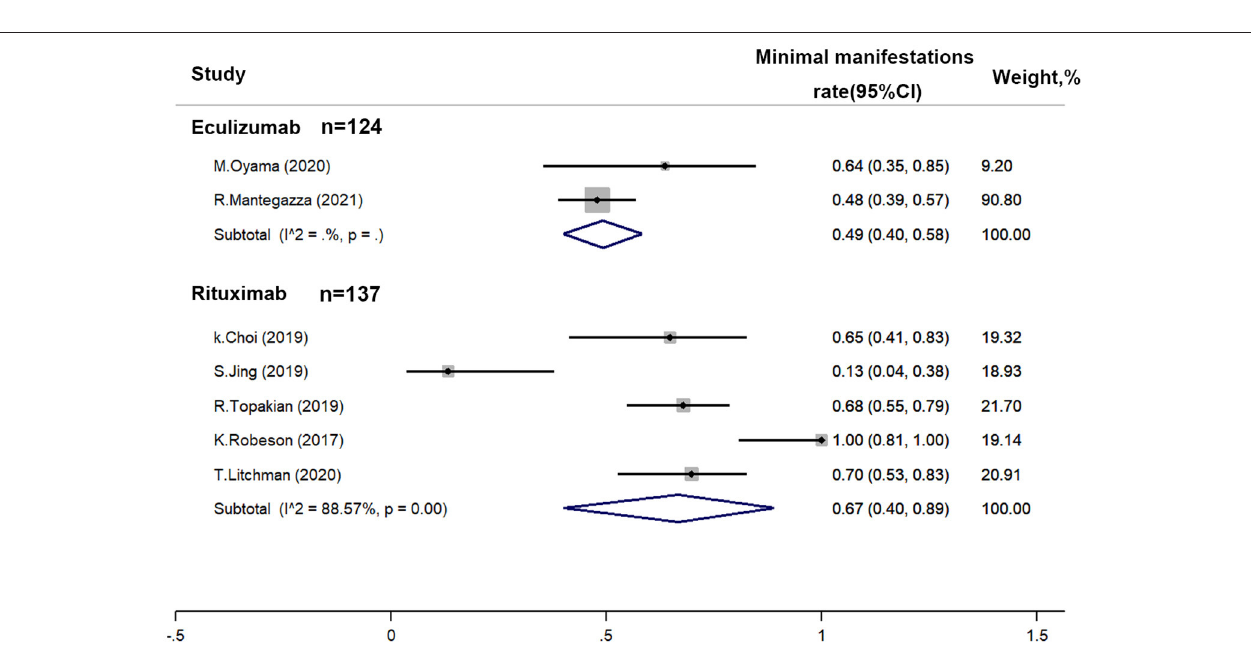
FIGURE 3 | Efficacy of immunotherapies in refractory myasthenia gravis based on the achievement proportion of minimal manifestations (MM) (Myasthenia Gravis Foundation of America post intervention status). A random-effect model was used for quantitative synthesis. No significant difference between the MM rate of rituximab and eculizumab was